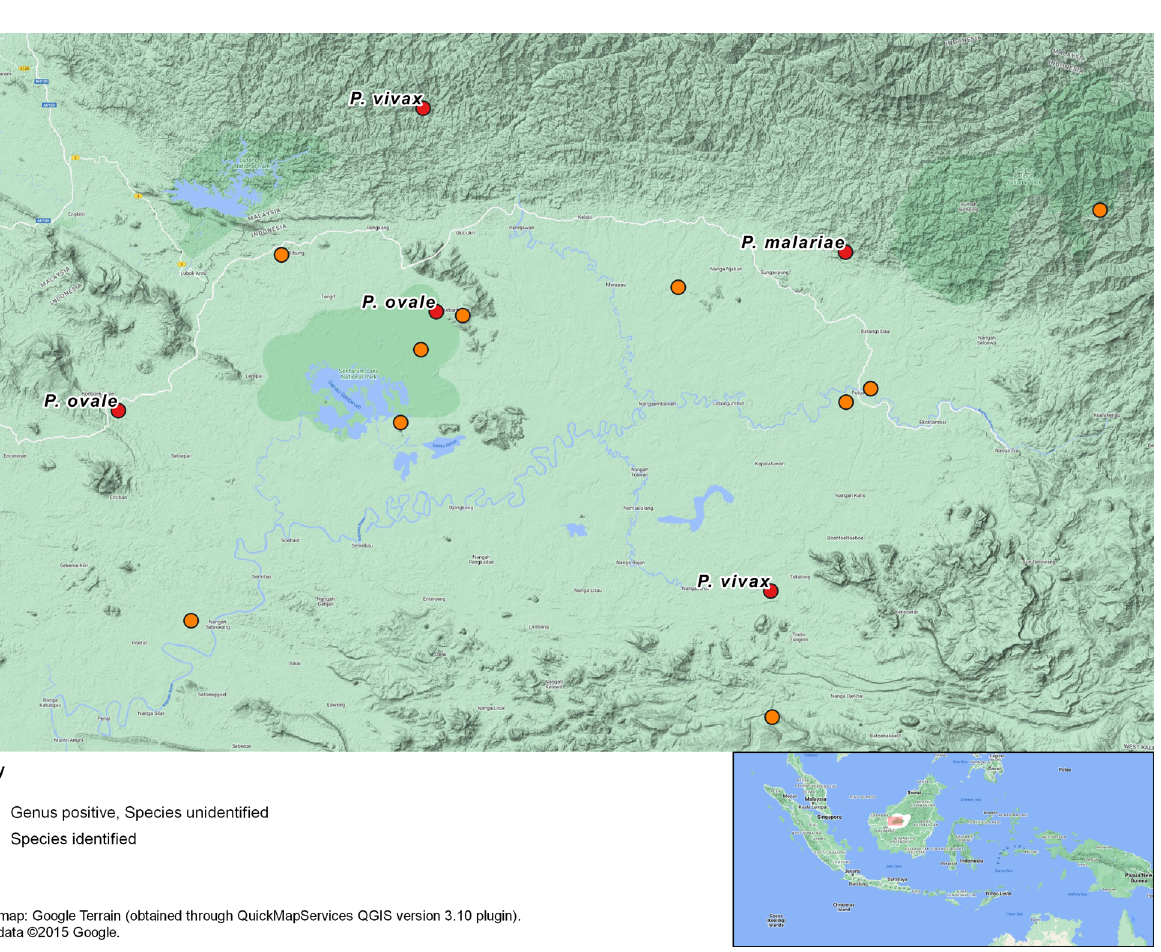
Figure 3. Map showing the locations at which the cases of PCR positive malaria were